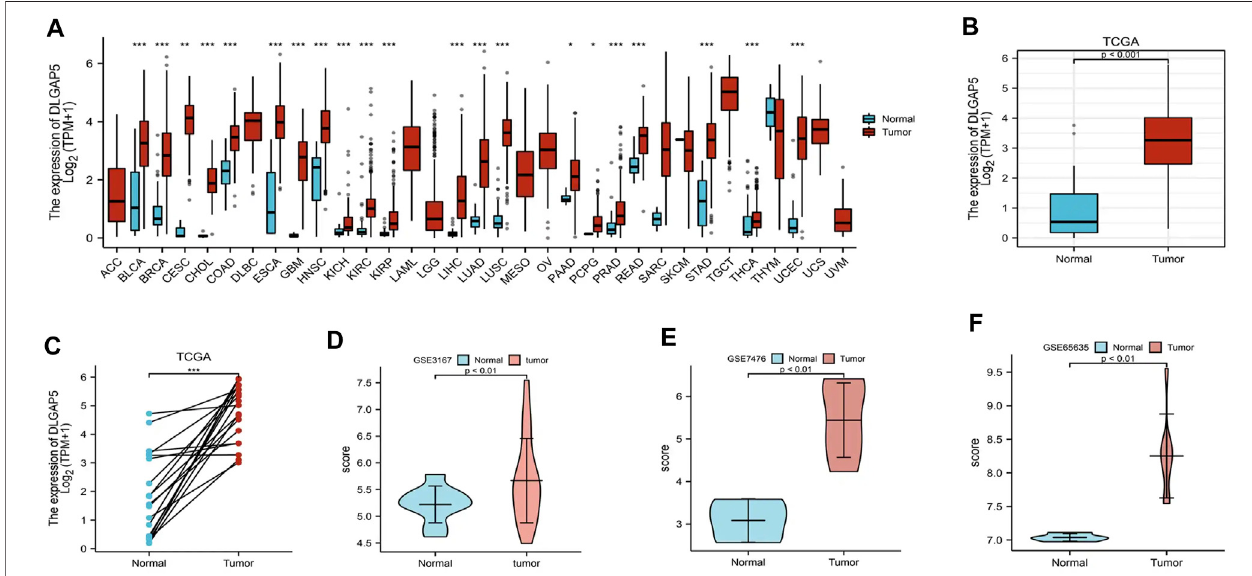
FIGURE 1 | Different expression level of DLGAP5. (A) A graph was constructed to show the expression levels of DLGAP5 between normal tissue with bladder tumor tissue for 33 types of cancers. High expression of DLGAP5 in bladder tumor (***). (B) The different expression of DLGAP5 in bladder tumor tissues compared to adjacent tissues from TCGA database (p < 0.001). (C) The different expression of DLGAP5 in bladder tumor samples and matched adjacent samples from TCGA database (***). (D) GSE3167, (E) GSE7476 and (F) GSE65635 from GEO database were used to verify high expression of DLGAP5 in bladder tumor (p < 0.01). *: p < 0.05, **: p < 0.01, ***: p <